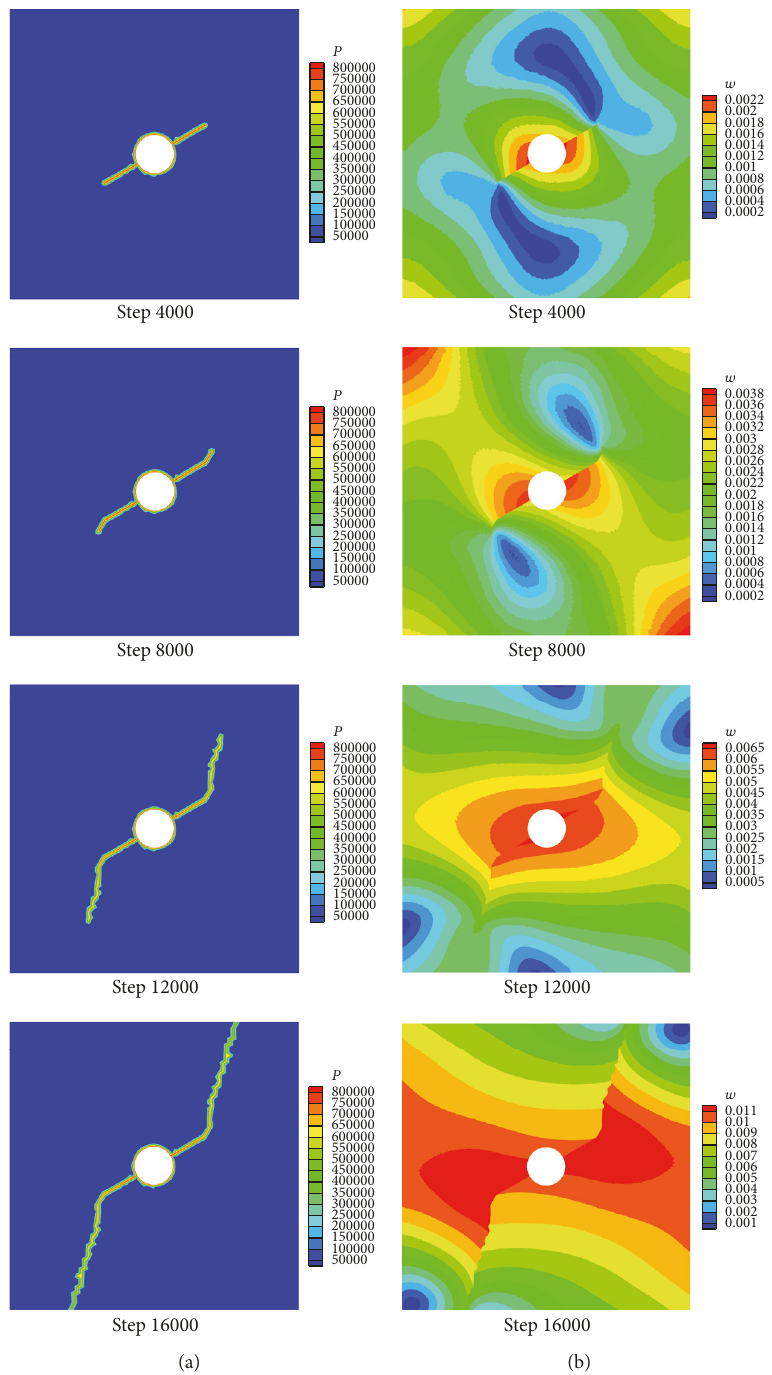
Figure 17: (a) Fracture geometry and hydraulic pressure distribution of model II; (b) displacement magnitude contours.